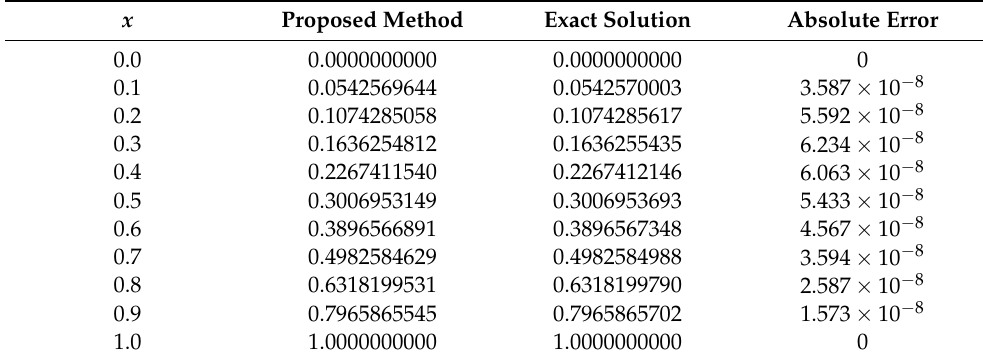
Table 6. Absolute errors for Problem 3 at h = 1/20.